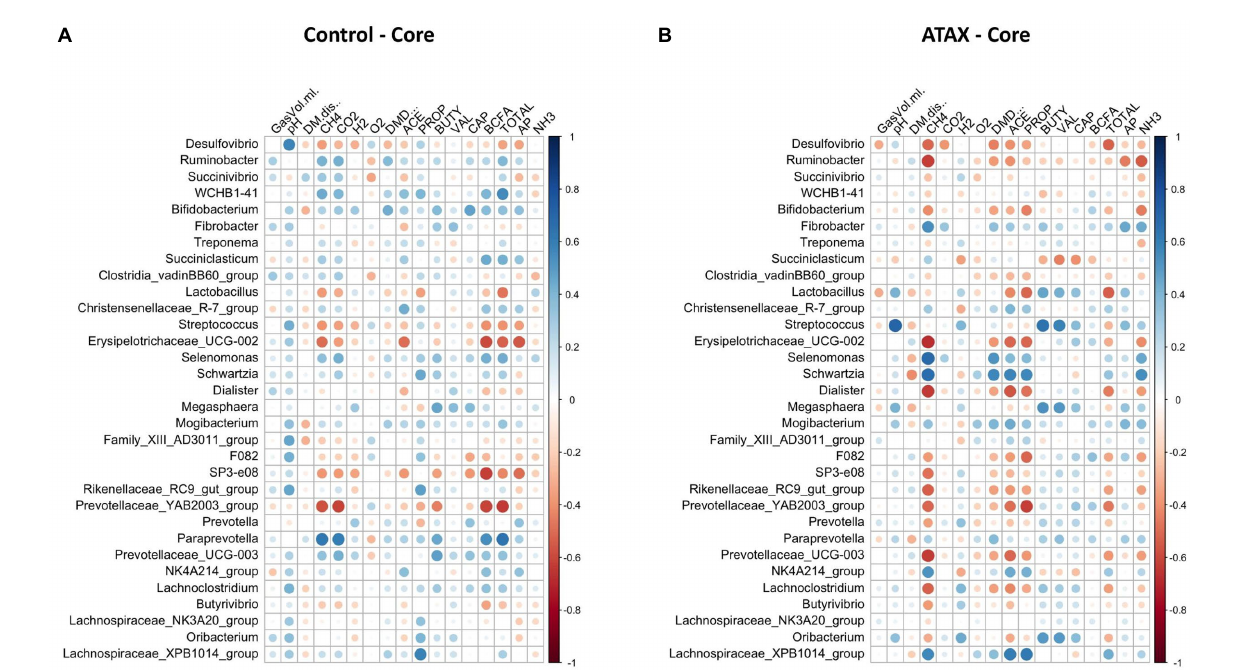
FIGURE 9 Spearman correlation analysis plots between the core bacteriome of (A) control samples and (B) A taxiformis samples and fermentation variables. Raw bacterial abundances were log-transformed prior to correlation. Only data from control and A taxiformis reactors was analyzed. GasVol.ml, total gas volume in mL; DM.dis., dry matter disappearance; CH4, methane; CO2, carbon dioxide; H2, hydrogen; O2, oxygen; DMD, dry matter digestibility; ACE, acetate; PROP, propionate; BUTY, butyrate; VAL, valerate; CAP, caproate; BCFA, branched-chain fatty acids; TOTAL, total VFA; AP, acetate: propionate ratio; NH3, ammonia. Individual sample values for all measurements are provided in the Supplementary